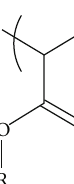
Figure 65: Chemical structure of